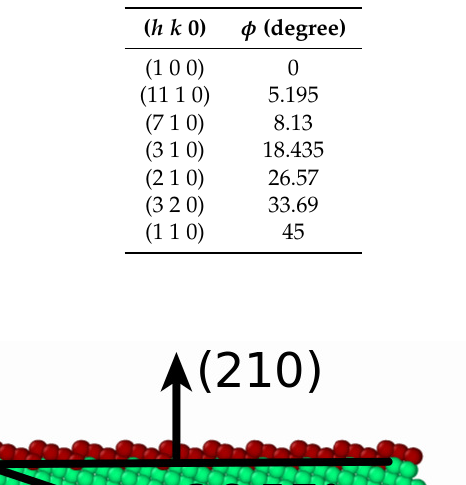
Table 1. Surfaces studied in the bcc and fcc samples. φ denotes the tilt angle towards the (100) plane (Equation (1)).